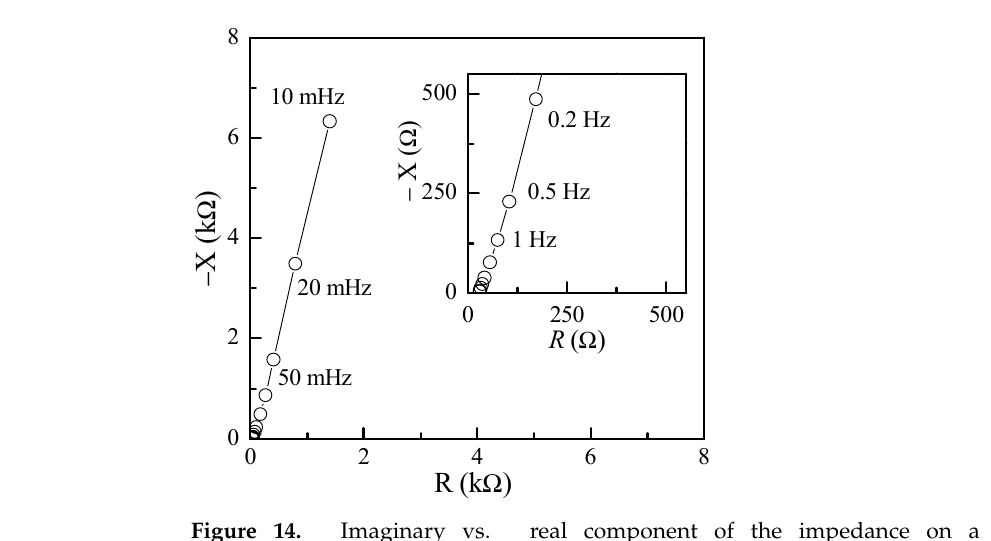
( b ) Figure 16. ( a ) Photograph of the sample holder used for bending tests. Two devices, each with an active area of about 1 cm 2 , were inserted into the stage, curvature radius of which was 5 mm; ( b ) picture taken 5 seconds after disconnecting the voltage supply used to charge the two capacitors (in series) inserted into the bending stage to 4 V: the LED remained lit by the charge stored in the devices for several seconds. 5. Conclusions In this paper, thin films prepared by applying inks developed from commercially available polypyrrole and graphene nanoplatelets were prepared and characterized by means of Raman and FTIR analysis and AFM measurements. Planar supercapacitor prototypes with an active area below ten mm 2 were also prepared by applying the inks on